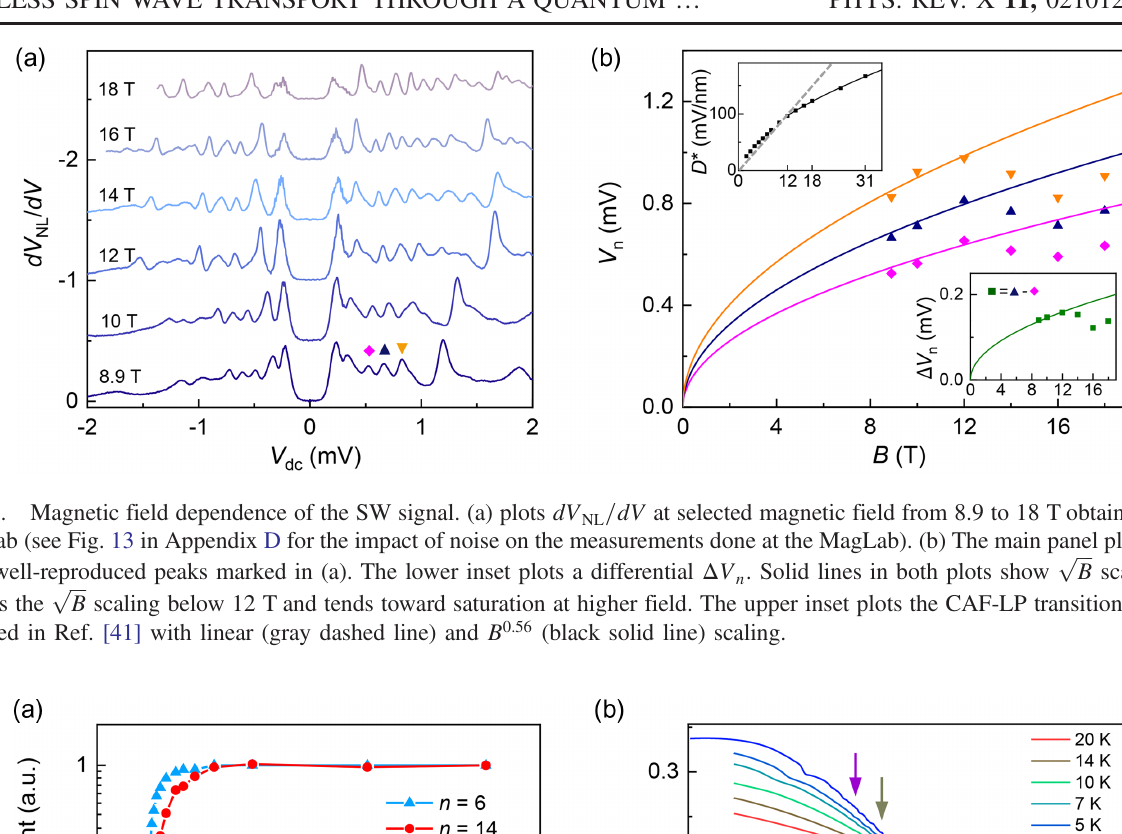
of ffiffiffiffi p n B scaling. V n